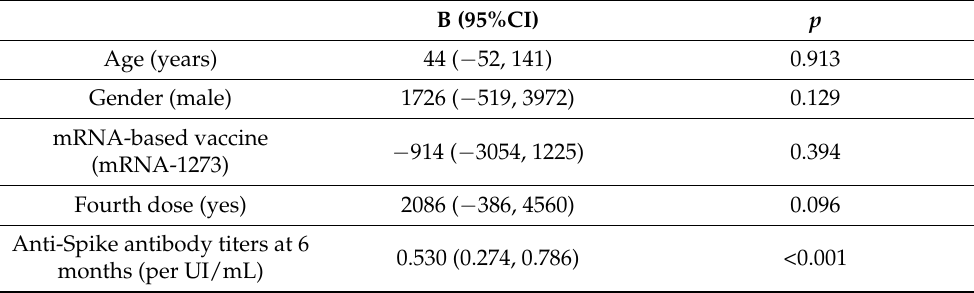
Table 1. Multivariate analysis using adjusted linear regression for factors associated with higher anti-spike antibody titers at 12 months.